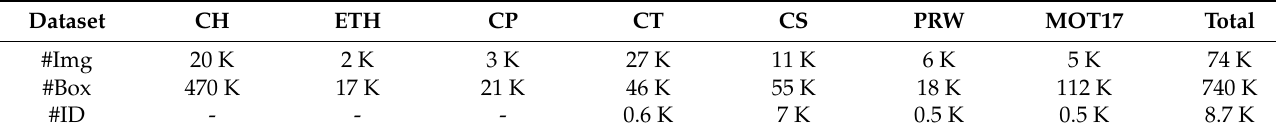
Table 1. Statistics of the hybrid